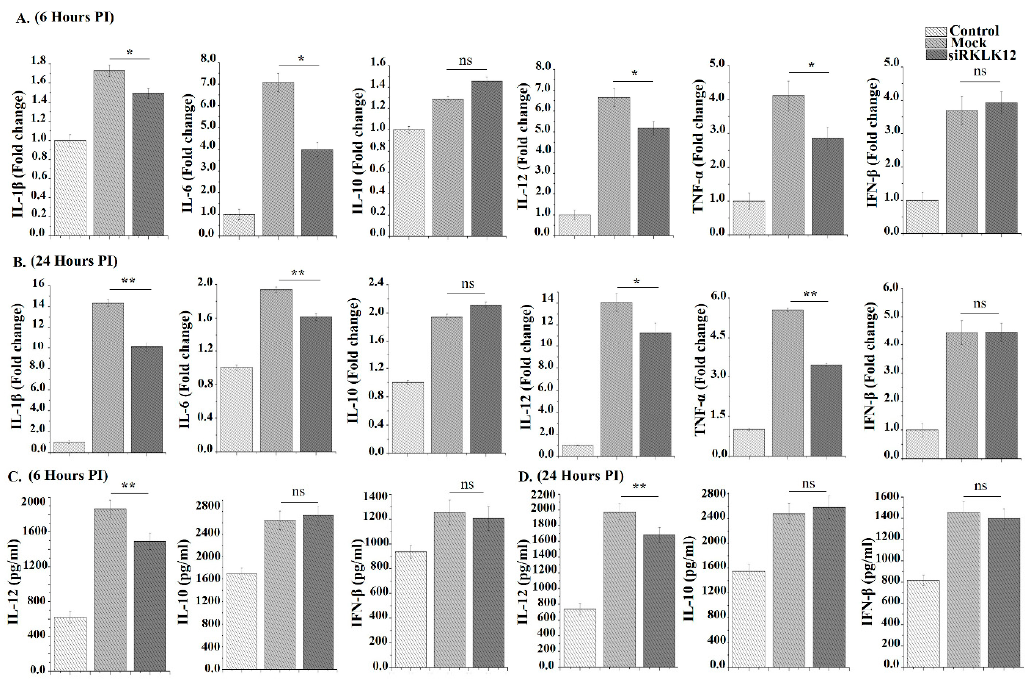
Figure 6. KLK12 regulates cytokines expression in the M. bovis C68004 infected murine BMDMs. ( A, B ) Murine BMDMs were transfected with KLK12 siRNA and negative control siRNA (20 uM). After 48 h of transfection, murine BMDMs were infected with M. bovis C68004 at a MOI of 10 and incubated